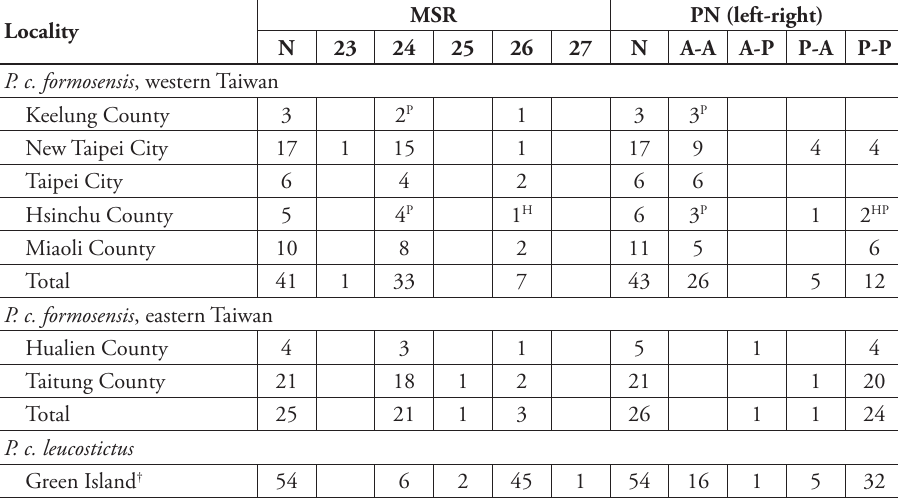
Table 2. Variation in scutellation characteristics (MSR, the number of scale rows around midbody; PN, the presence of a postnasal: A = absent or P = present) of Plestiodon chinensis in Taiwan and Green Island. MSR PN Locality